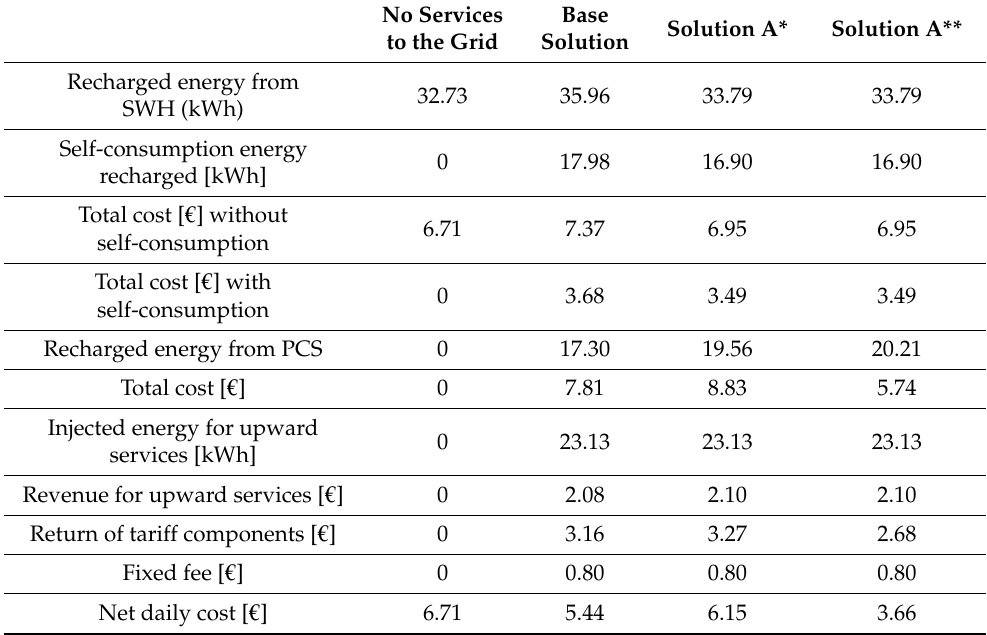
Table 30. Results for mobility pattern 2—UVAMbis (Scenario